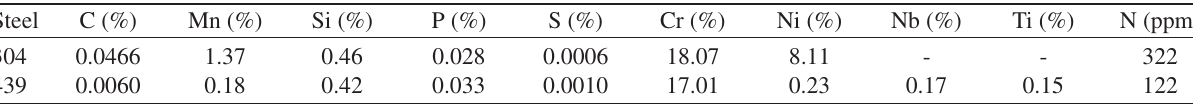
Table 1. Chemical Composition of the 304 and 439 Stainless